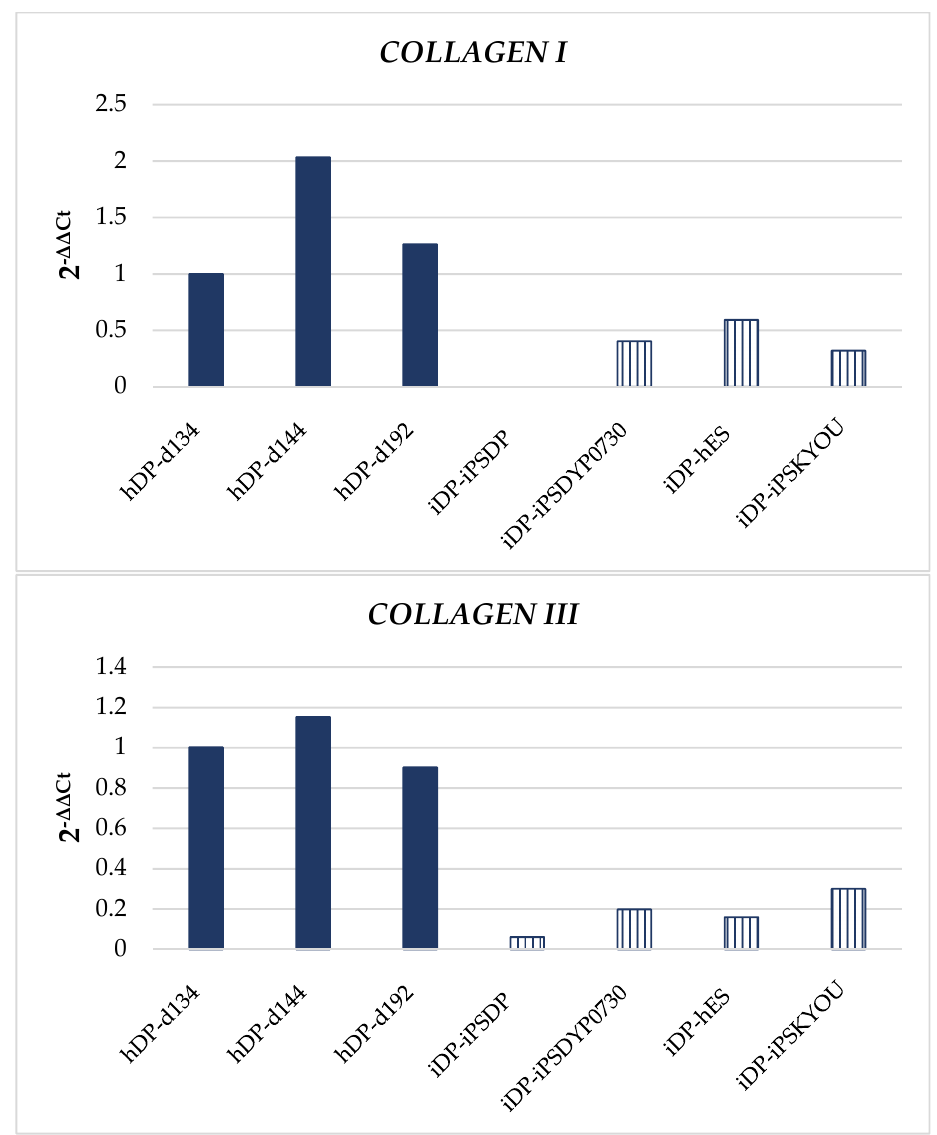
Figure 5. Expression of specialized markers in the dermal spheroids. Quantitative PCR analysis: VERSICAN , ALCALINE PHOSPHOTASE ( ALP ), VIMENTIN , FIBRONECTIN , NESTIN , COLLAGEN I , COLLAGEN III.